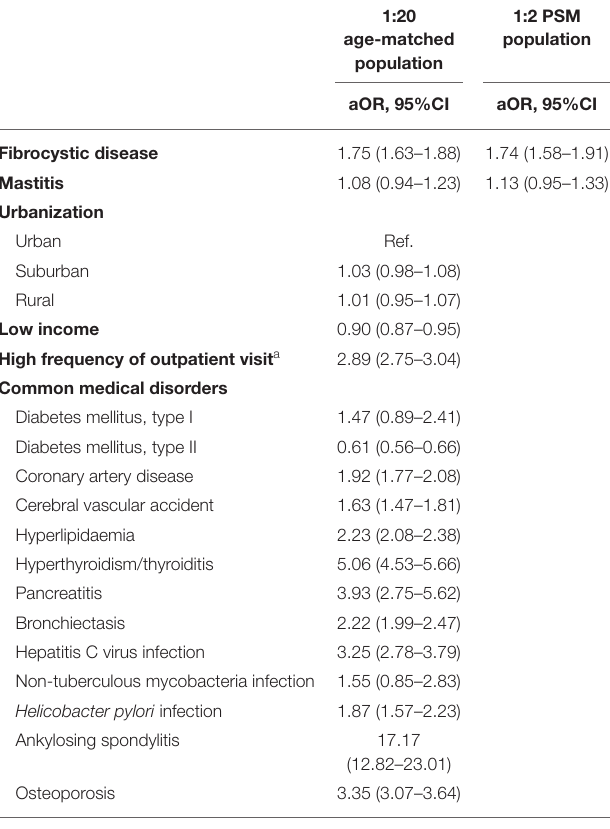
TABLE 2 | Conditional logistical regressions for the estimation of the risk for SS.